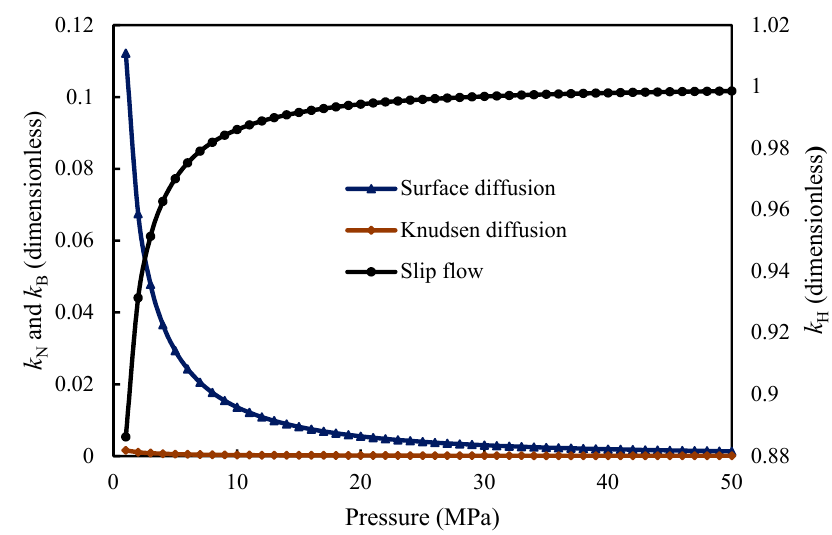
Figure 6. Relationship between contribution rate and pressure.